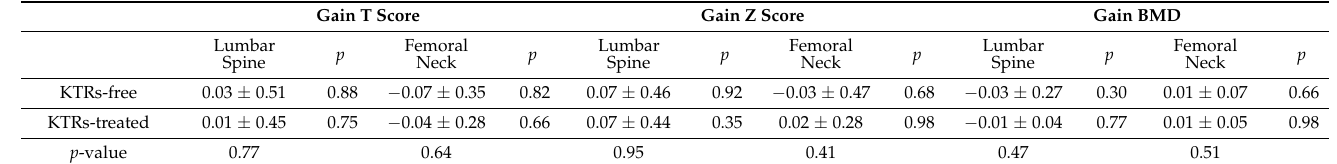
Table 4. T-score, Z-score, and BMD gains at 2 to 3 years follow-up in untreated and treated bisphos- phonate and/or calcimimetics and/or active vitamin D